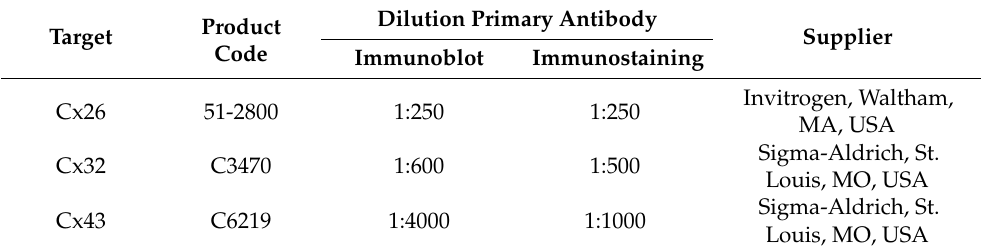
Table 4. Primary antibodies for immunoblot and immunostaining. Target protein, product code, dilution, and supplier of the selected primary antibodies are listed. Product Target